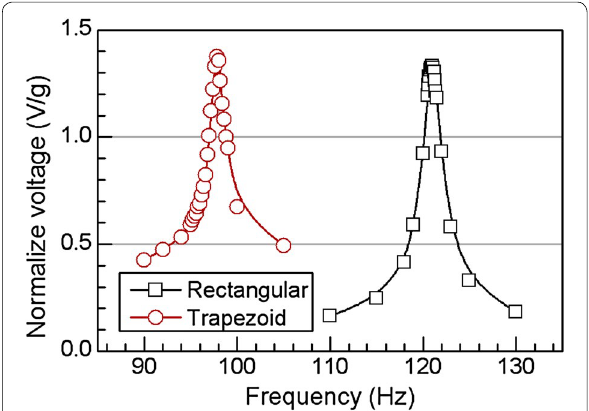
Fig. 6 Normalized open circuit voltage of the micro-fabricated curled cantilever based energy harvester under vertically induced vibration